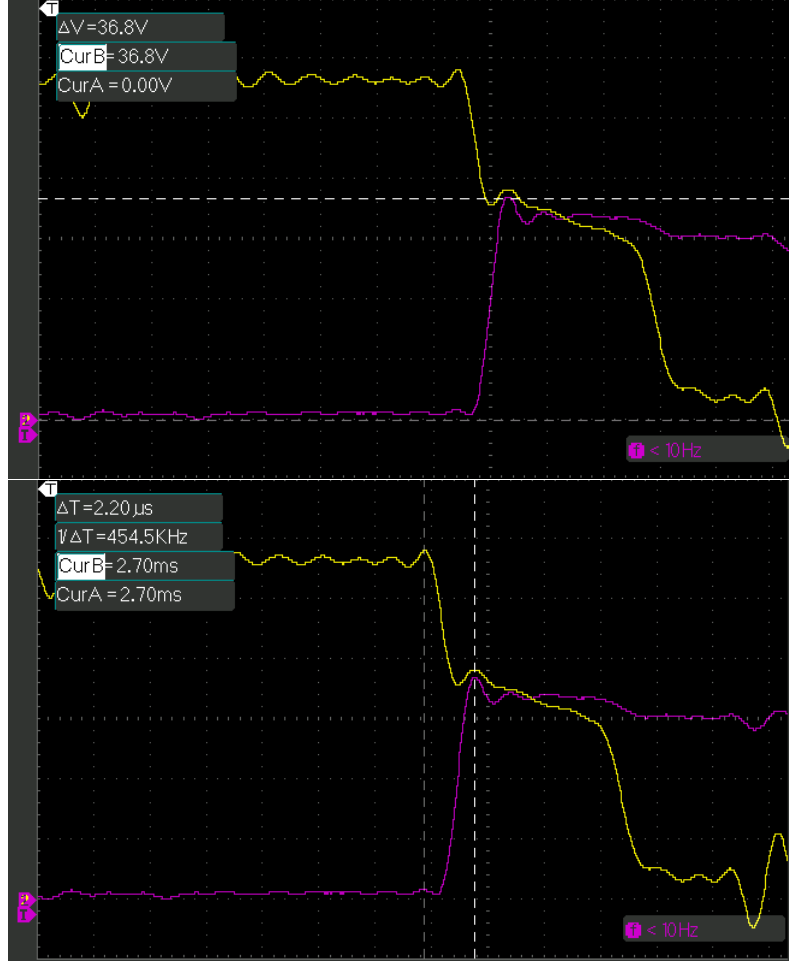
Figure 16. R 4 = 10 Ω turn-off waveform.